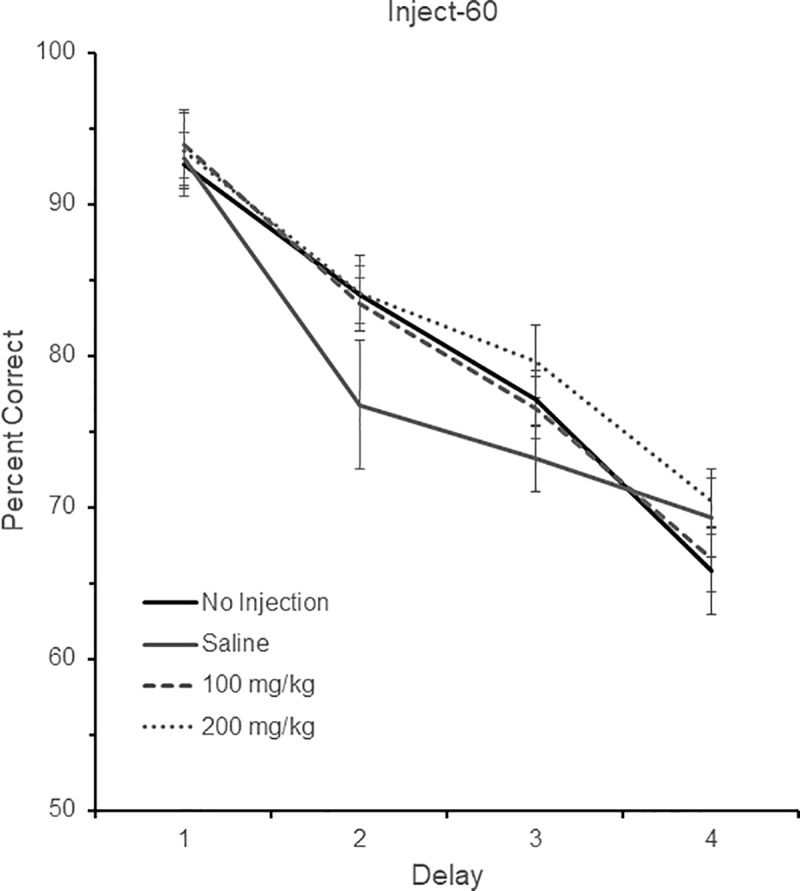
DMS performance in the Inject-60 condition.DMS performance following no injection, saline, 100 mg/kg aniracetam, and 200 mg/kg aniracetam in the Inject-60 condition. A total of eight birds were tested. Four birds were tested with delays of 0, 1, 2, and 4 sec (Delay set 1), one was tested with delays of 0, 2, 4, and 8 sec (Delay set 2), two were tested with delays of 0, 3, 6, and 9 sec (Delay set 3) and one was tested with delays of 0, 5, 10, and 20 sec (Delay set 5). Chance is 50% correct. Error bars are +/- SEM.